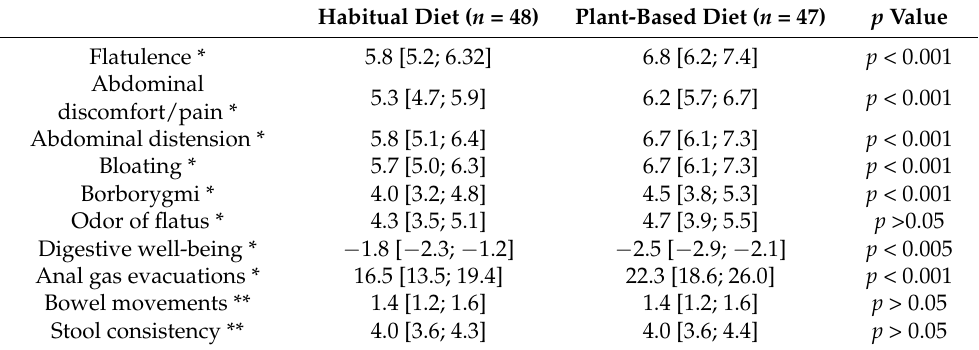
Table 1. Effects of the plant-based diet on gas-related symptoms and frequency of anal gas evacuations.